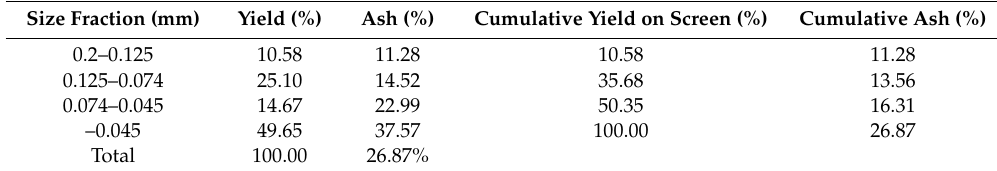
Table 1. Size distribution of the coal sample.